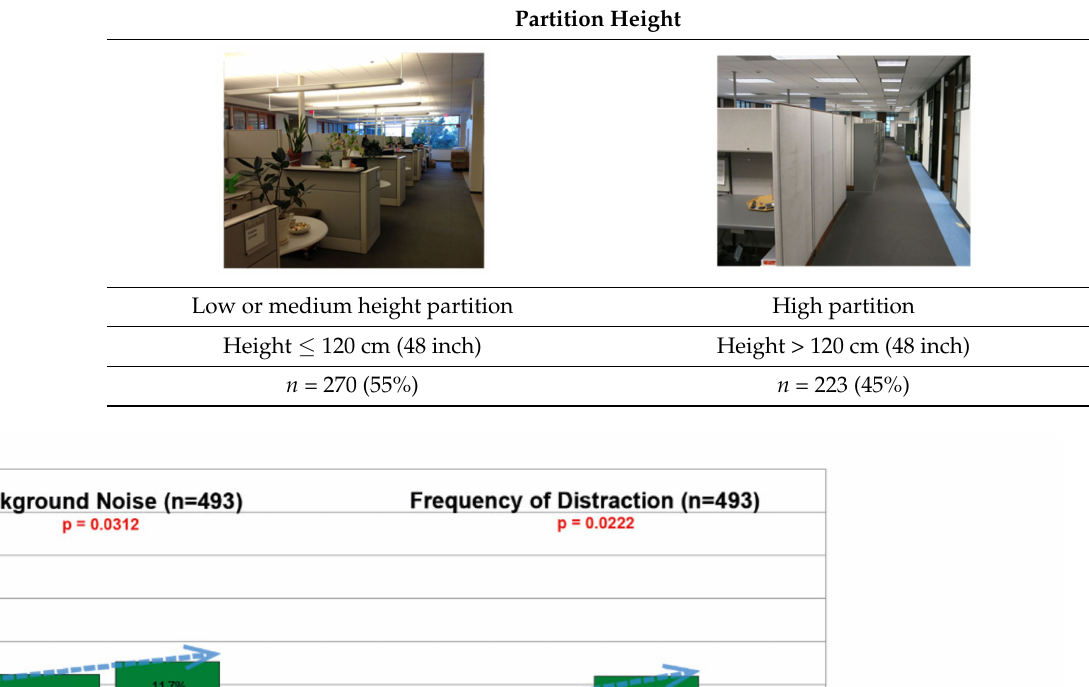
Table 13. Distribution of partition height in open-plan offices ( n = 493).